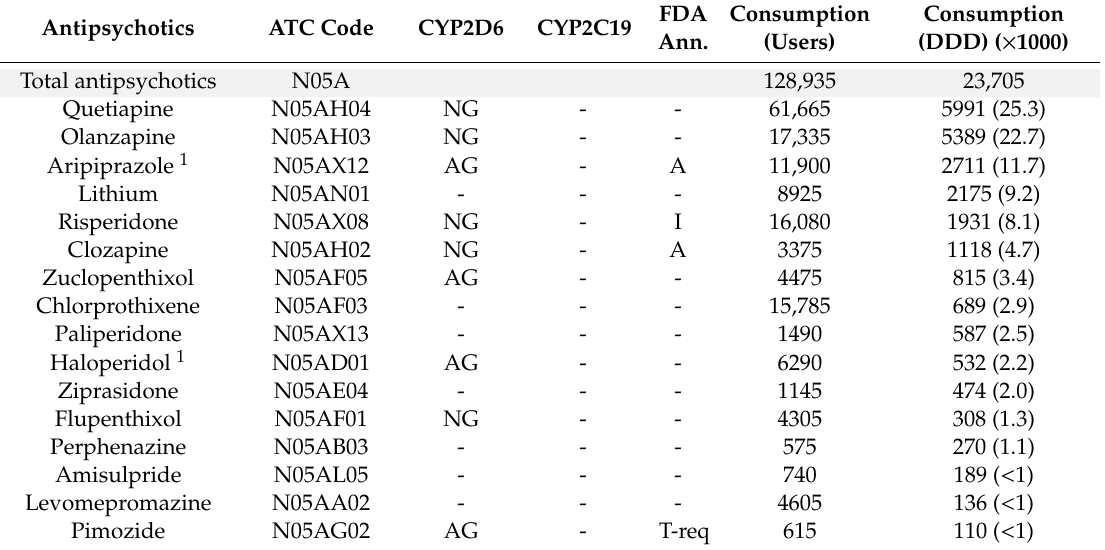
Table 3. Consumption of antipsychotics.